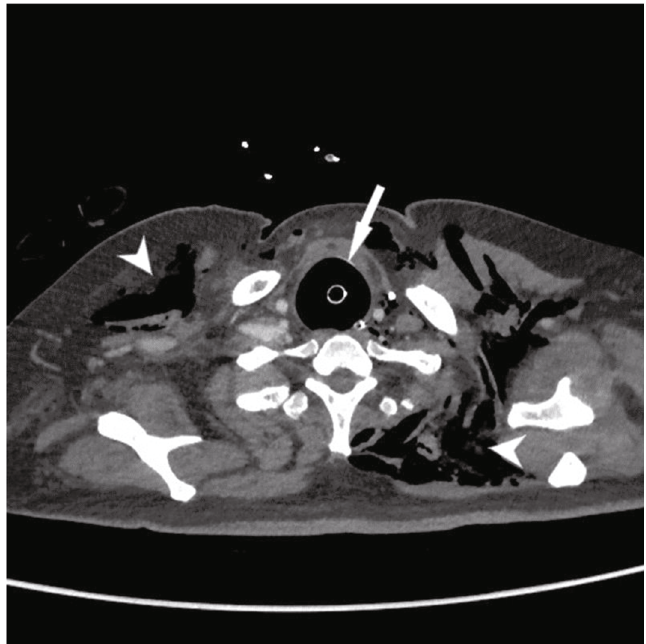
Figure 2: Neck CT. An overin fl ated tracheal tube cu ff and dilated trachea can be seen compressing the cervical